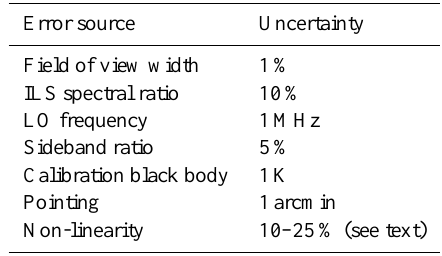
Table 1. Uncertainties in instrumental parameters used to determine the error budget for the HCl and ClO profile retrievals from the SIR channel of the TELIS instrument. ILS stands for instrumental line shape and LO for local